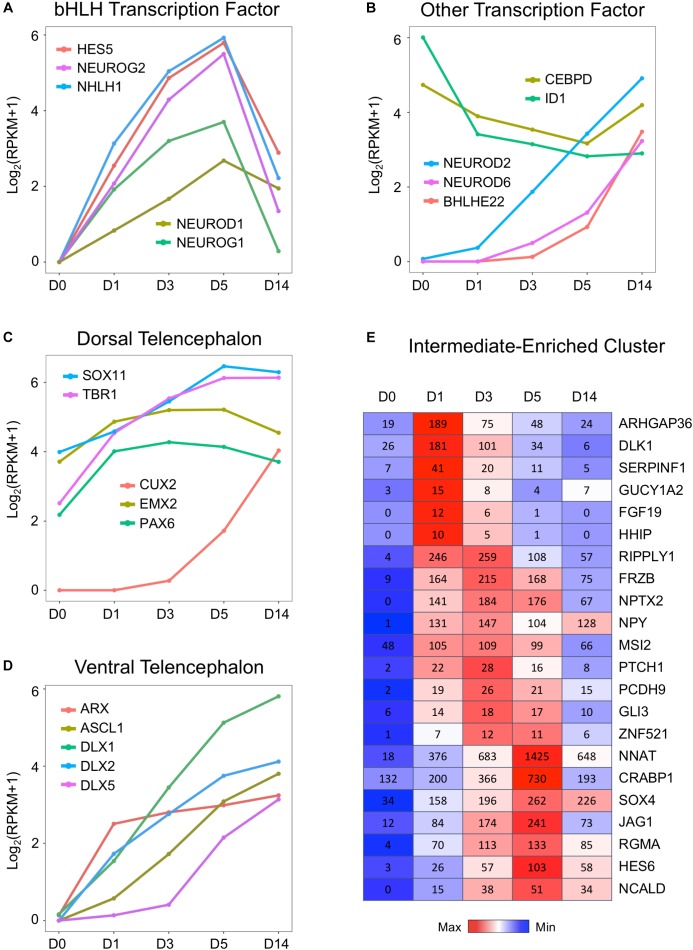
Upregulation of neural transcription factors during chemical reprogramming of astrocytes into neurons. (A) Rapid activation of the bHLH family of transcription factors involved in neurogenic development process during the chemical conversion process. Note that these neural transcription factors were downregulated at D14 when neuronal conversion was completed. (B) Additional neural transcription factors that were upregulated by small molecules, such as NEUROD2/6 and BHLEH22. In contrast, DNA binding inhibitor ID1 and astrocytic enhancer binding CEBPD were downregulated. (C) Genes involved in dorsal telencephalon development were upregulated during core drug treatment. Note that cortical neuron marker genes TBR1 and CUX2 were significantly increased by small molecules. (D) Transcription factors involved in ventral telencephalon development such as ASCL1 and its downstream targets ARX and DLX were also upregulated. (E) Representative gene expression waves that peaked at D1, D3, and D5 during the chemical conversion process. The first wave peaked on D1 included several hedgehog genes such as ARHGAP36 and DLK1. Color scaled within row and FPKM values presented.